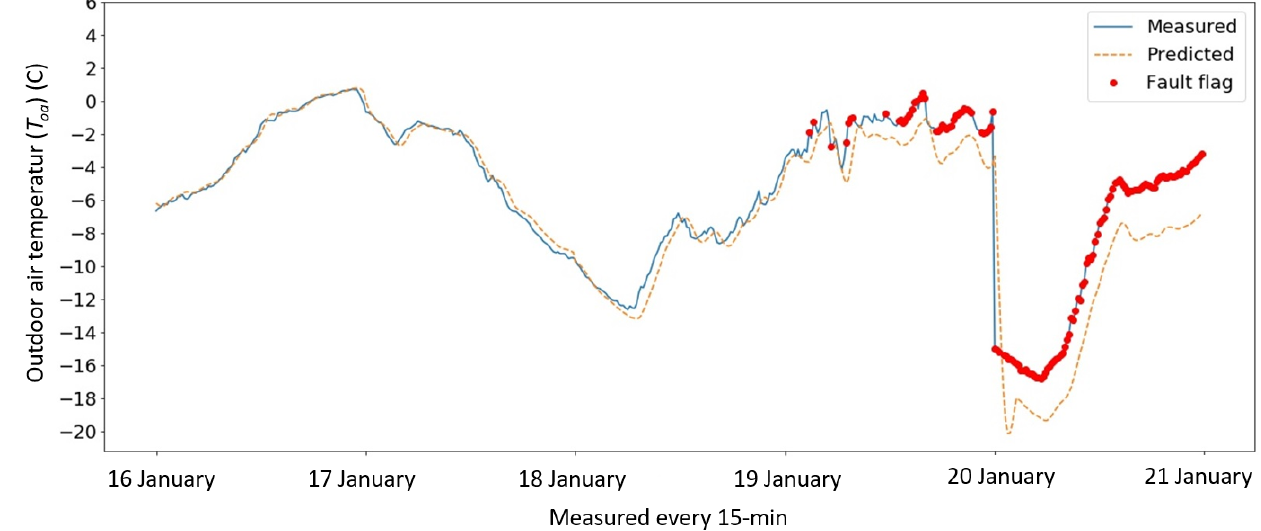
Figure 10 . Measurements and predictions of T oa with artificial faulty data .